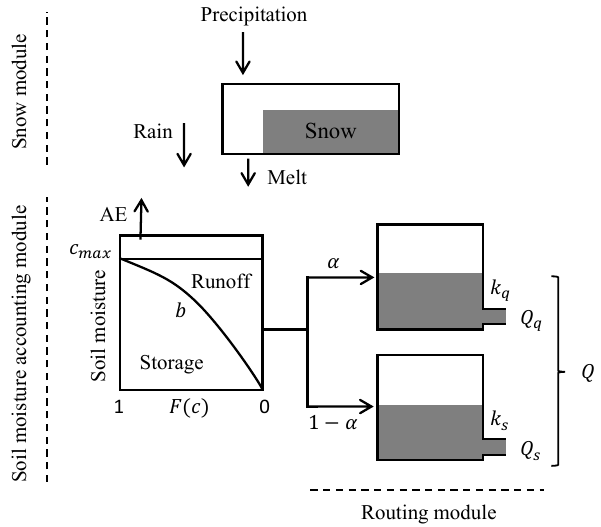
Figure A1. Schematic representation of the rainfall–runoff concep- tual model structure used.